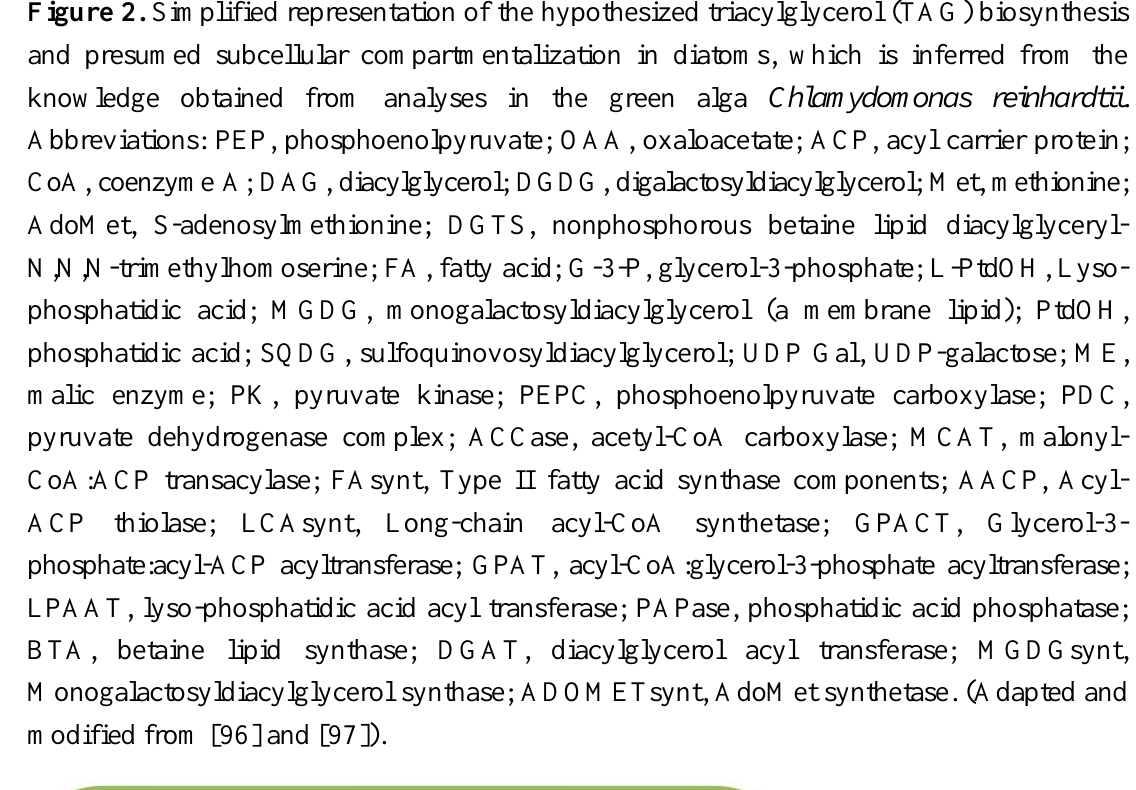
Figure 2. Simplified representation of the hypothesized triacylglycerol (TAG) biosynthesis and presumed subcellular compartmentalization in diatoms, which is inferred from the knowledge obtained from analyses in the green alga Chlamydomonas reinhardtii